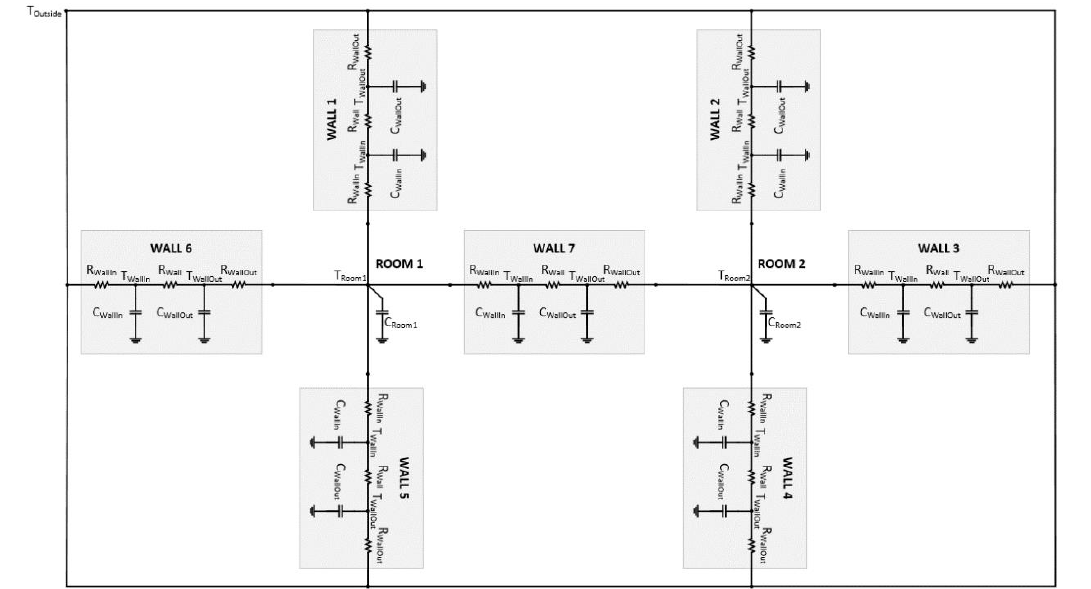
Figure 4. Defining walls using 3R2C structures.